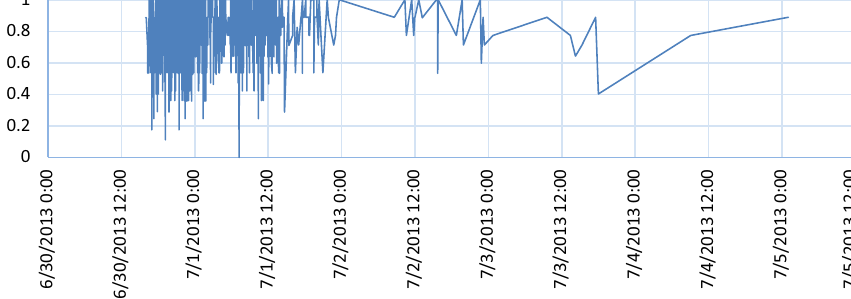
Figure 12. Individuals toleration levels